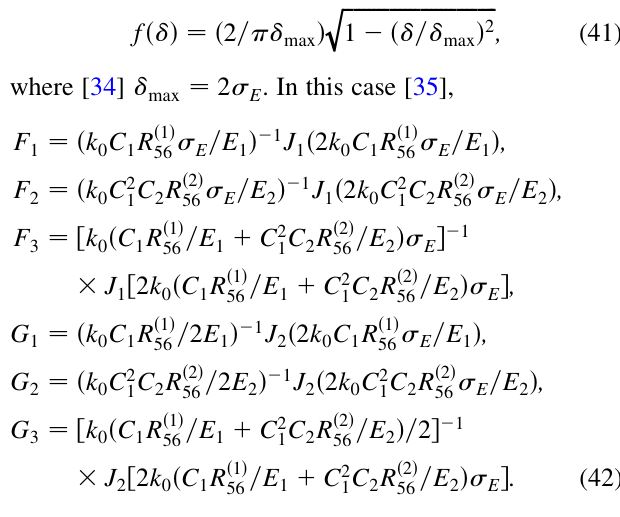
FIG. 9. (Color) Curves show the analytical microbunching gain between the entrance of the BC1 chicane at 215 MeVand the exit of the L2 linac at 1.7 GeV, for a bunch with initial current of 50 A. The gain is shown as a function of the modulation’s initial wavelength (cid:6) 0 . Plotted points show the gain in 4-million particle simulations of a 500-pC bunch with an initial trapezoidal longi- tudinal profile with flattop length of 2 mm and flattop current of 50 A. (a) Gaussian energy distribution with initial rms energy spread of 3 keV. (b) Semicircular energy distribution from a matched laser heater, with initial rms energy spread of 10